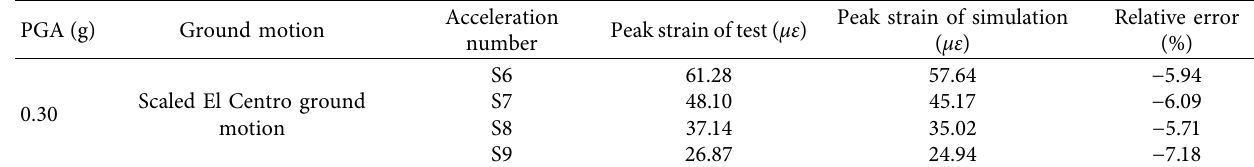
Figure 18: Comparison of strain under 0.30g scaled El Centro ground motion. (a) Strain time history of S6. (b) Strain time history of S7. (c) Strain time history of S8. (d) Strain time history of S9. Table 12: Comparison of peak strain between test and